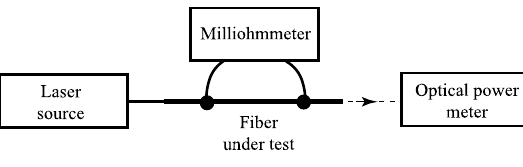
Fig. 1. A simplified scheme of the experimental setup.